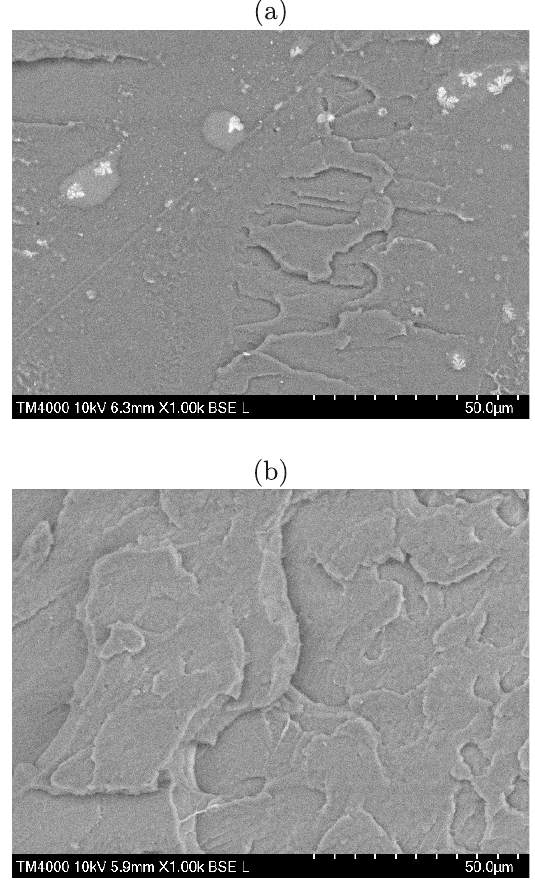
Figure 5. Stress–strain curves for virgin PLA (vPLA), recycled PLA (rPLA), virgin PLA mixed in the presence of PBO (vPLA+PBO), and recycled PLA mixed in the presence of PBO (rPLA+PBO), highlighting the recovery of the mechanical properties of rPLA after chain